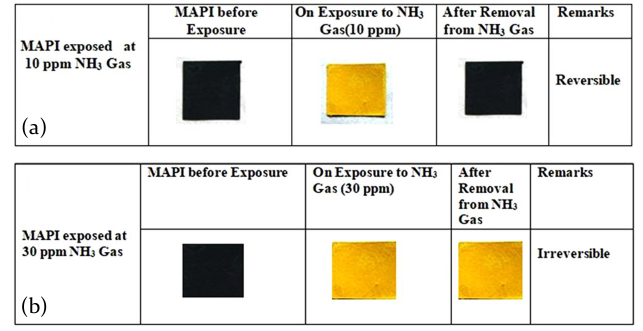
Figure 20. Photographs of the MAPbI 3 film exposed to ( a ) 10 ppm NH 3 gas, which allows a reversible process, and to ( b ) 30 ppm, which induces an irreversible film transformation. Adapted